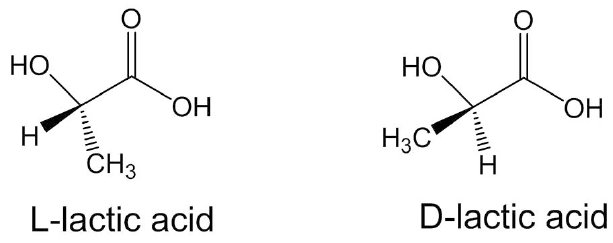
Figure 1. Enantiomer structures of PLA monomer [32].